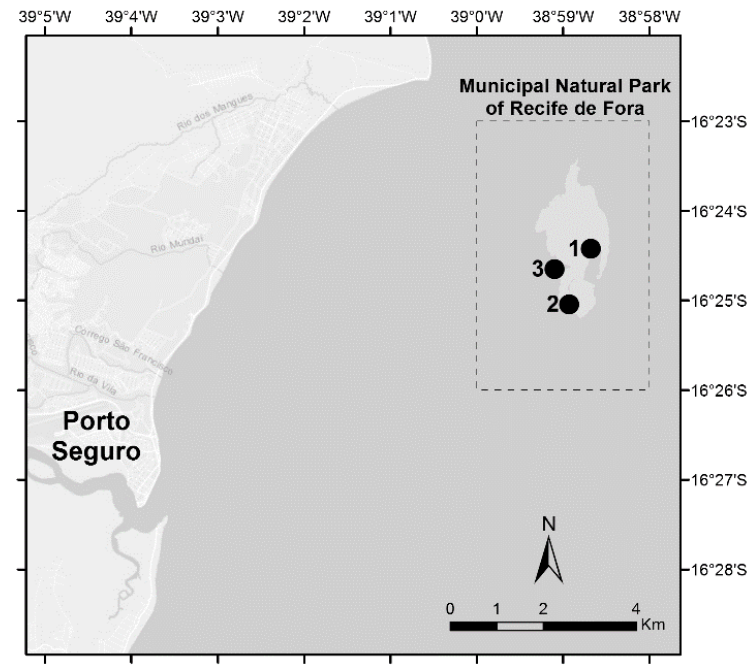
Figure 1. Study area of the Recife de Fora Marine Protected Area in the Southwestern Atlantic, Brazil. Reef sites : 1) Taquaruçu, 2) Mourão, 3) Funil. (Adapted from Marangoni et al. 2019).